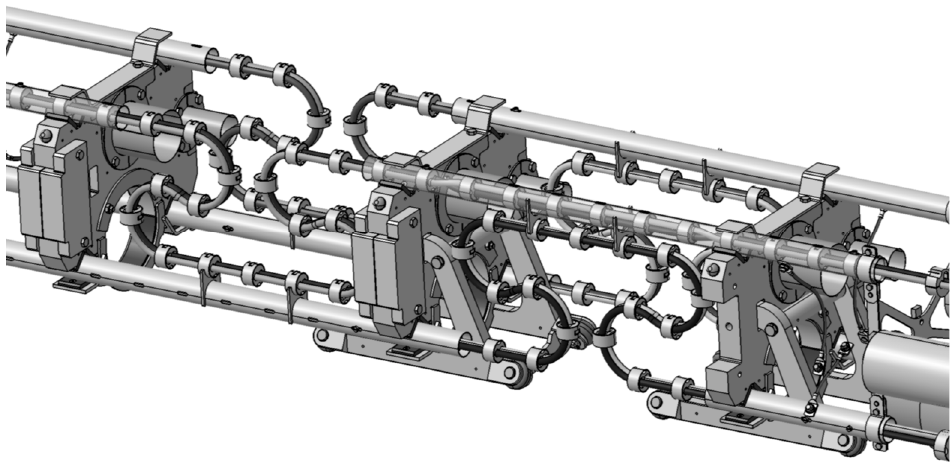
Figure 14. Thermal compensation loops on the busbar pairs on the support plates.